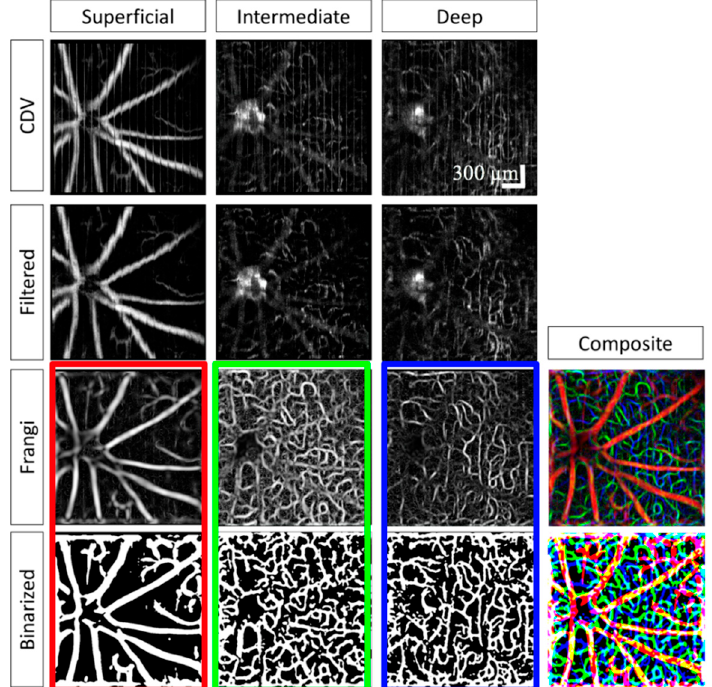
Figure 15. Results of CDV angiography and additional filtering. Original CDV images (Row 1) are manually filtered to remove bulk motion artifacts due to breathing and heart beat (Row 2). A Frangi vesselness filter is then applied to improve SNR (Row 3). Lastly, the Frangi-filtered images are binarized using adaptive filtering (Row 4). Columns 1–3 show different vascular plexuses, and Column 4 shows composite images of the Frangi-filtered and binarized angiograms. Scale bars indicate 300 μ m.